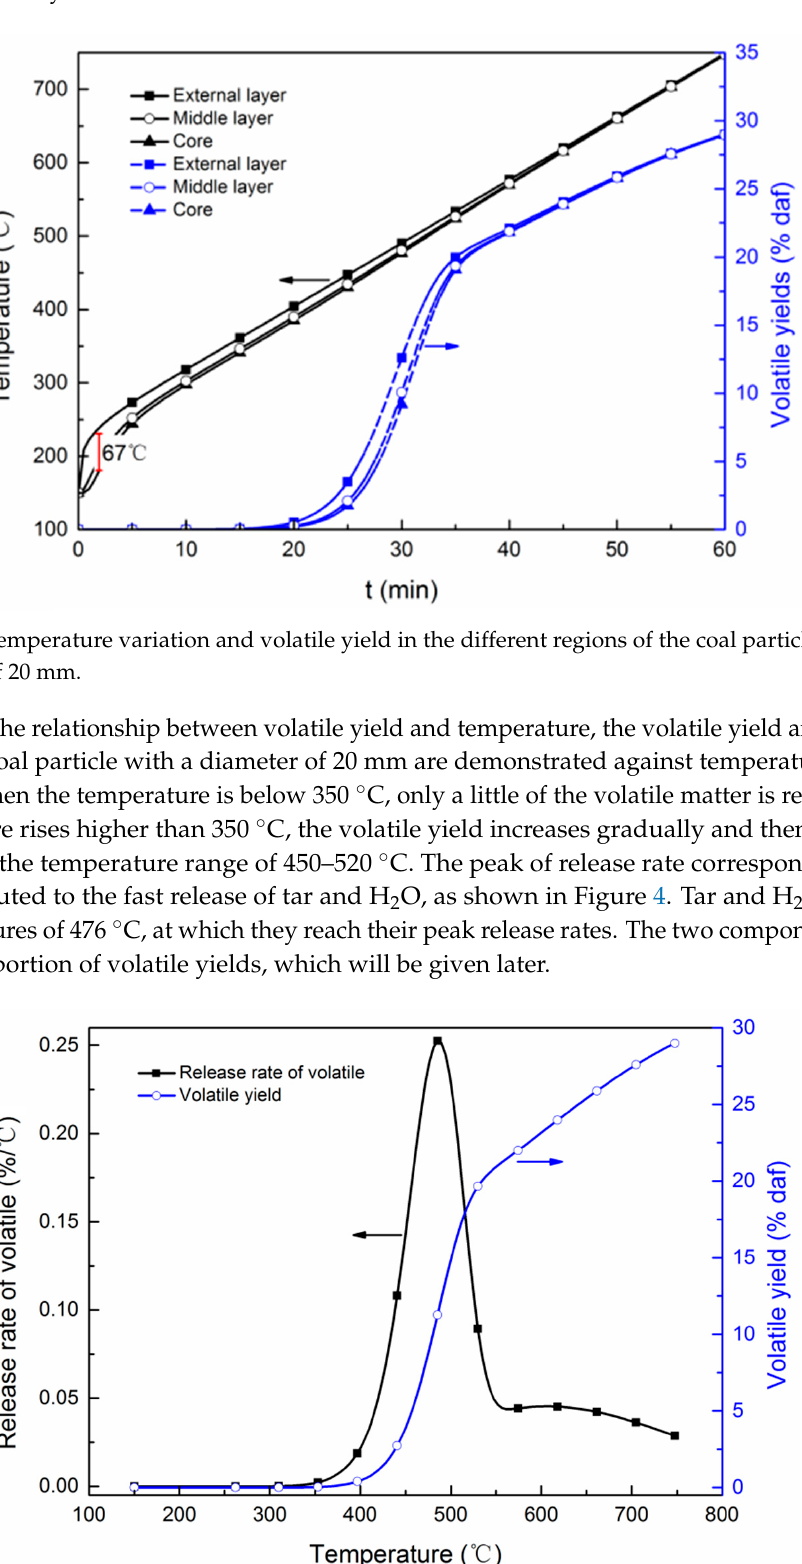
Figure 3. Volatile yield and its release rate from the coal particle as a function of temperature ( d = 20 mm).